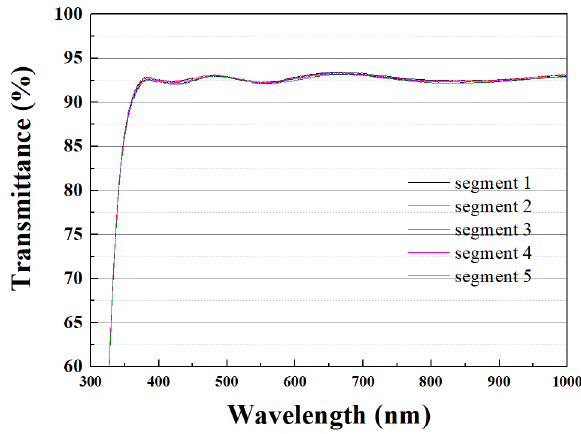
Figure 6. Transmission spectra of SiO 2 thin film deposited on different segments from one to five. Table 1. Optical constants of SiO 2 thin films with different